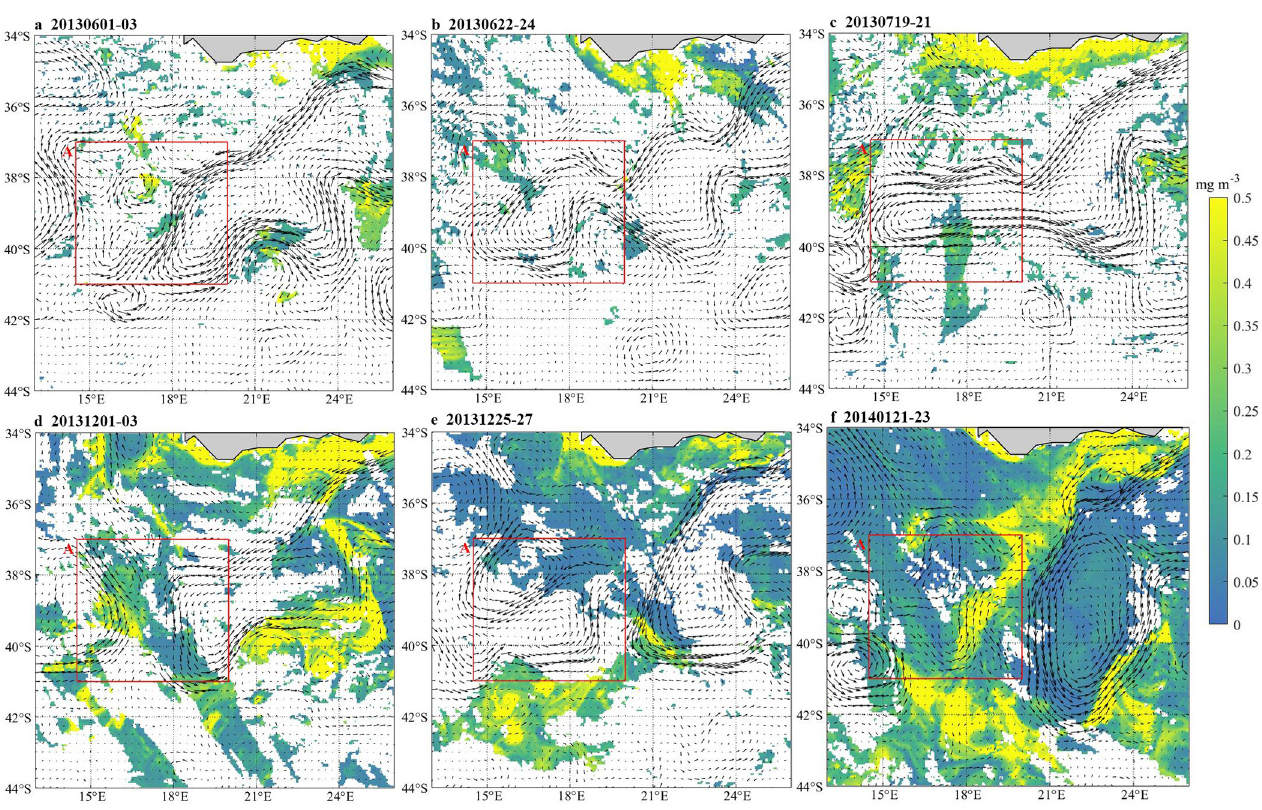
Fig 4. The 3-day average of surface Chl-a and flow field around Box A on 2013.6.1-3(a), 2013.2.22-24(b), 2013.7.19-21(c), 2013.12.1-3(d), 2013.12.25-27(e), and 2014.1.21-23(f). Color bars denote Chl-a concentration (unit: mg � m -3 ) and black arrows indicate the direction of the Agulhas Current.